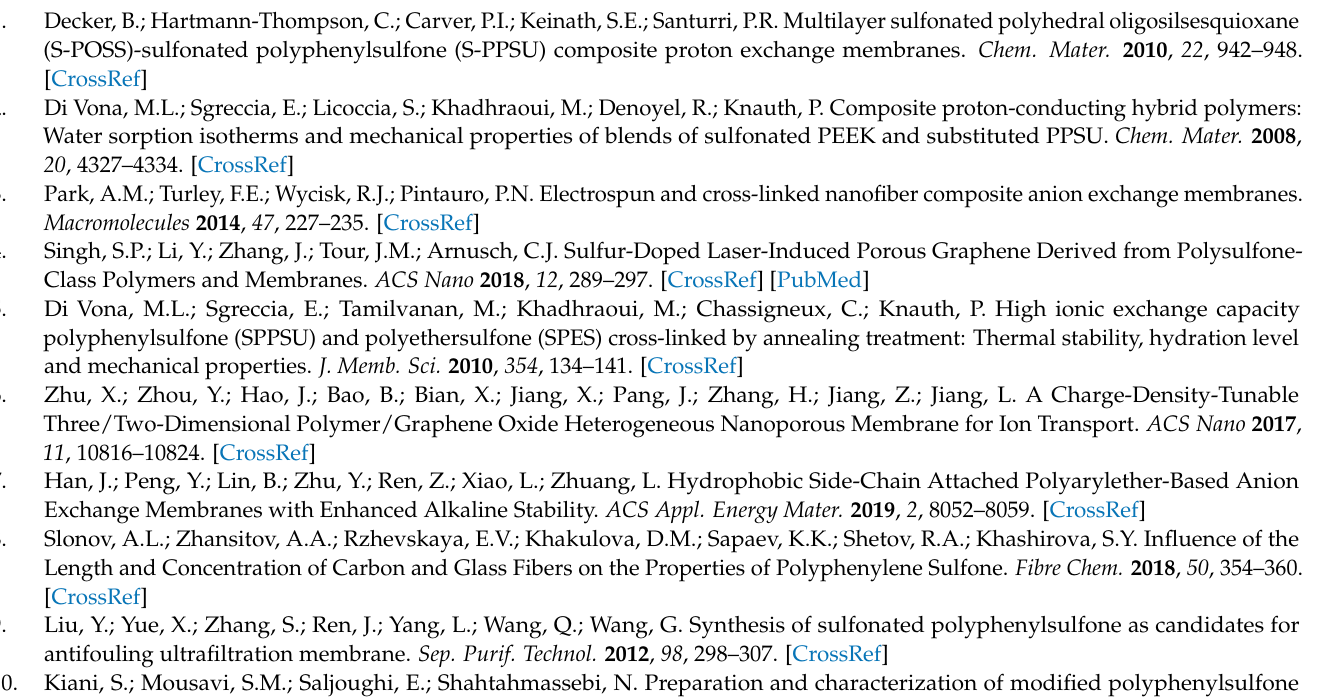
strength properties; Figure S3: SEM image of membranes for gas separation (a) sPPSU, (b) PIM- 1/sPPSU; Figure S4: SEM images of the fibrous membrane surfaces with respect to the PPSU with PEG concentration in the electrospinning solution (a) 0 wt.%; (b) 2 wt.%; (c) 5 wt.%; and (d) 10 wt.%; and mechanical properties and water contact angle; Figure S5: SEM images of the sPPSU membranes surface and cross-section, water contact angles, and filtration performance with PEG concentration; Figure S6: PPSU/GO-based blended membranes (a) AFM and SEM images of PPSU; (b) AFM and SEM images of PPSU/GO; and water contact angle, surface zeta potential as a function of pH, me- chanical properties using tensile tests, and time-dependent fluxes of pure water, and BSA protein; Figure S7: Modified membranes (a) cross section, top surface SEM images and 3D AFM images; (b) rejection efficiency; and (c) flux recovery and fouling resistance ratio; Figure S8: PPSU embedded with Ag-MWCNT membranes: 3D AFM images, low and high magnification SEM images, and (a) zeta potential as a function of pH; (b) contact angle and porosity; Figure S9: Modified PPSU and PPSU/Zn-MOF membranes: (a and b) surface and cross-section images; (c) zeta potential versus pH; and (d) pure water hydraulic permeability; Figure S10: The ionic cross-linking reaction between sPPSU and HPEI at the membrane